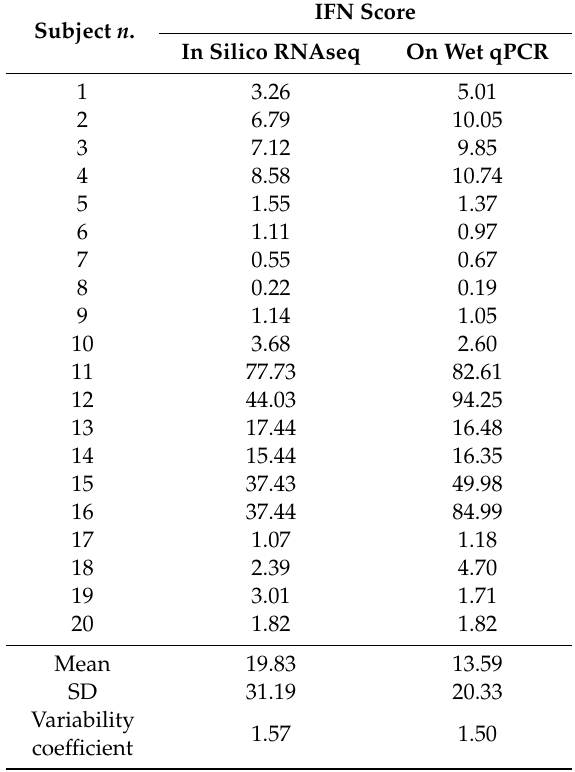
Table 3. Comparison of interferon (IFN) scores determined in twenty subjects by both qPCR and RNAseq by χ 2 contingency analysis ( p -value = 0.405, not significant).